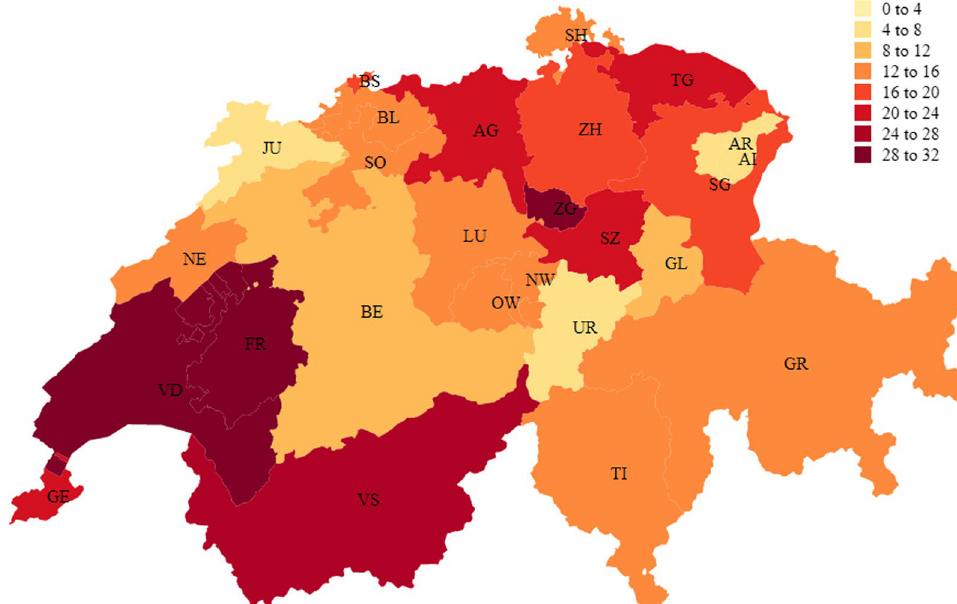
Fig. 5 Growth in the stock of foreigners relative to initial population from 1985 to 2016 in % by canton. Notes: Mapped variable: ( I i ,2016 − I i ,1985 )/ Pop i ,1985 · 100 . The range (x to y) includes the lower number (x) and excludes the upper number (y). Source: Own calculations based on data from Federal Statistical